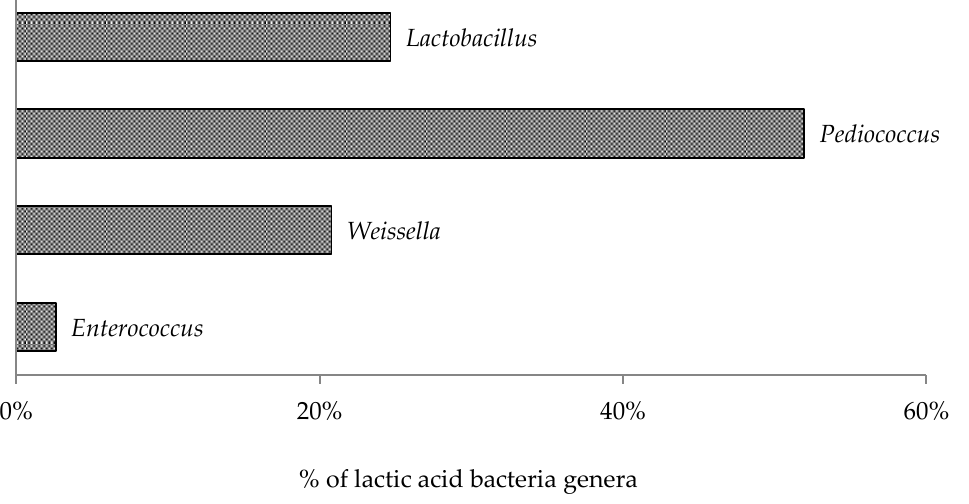
Figure 2. Frequency of lactic acid species isolated from alfalfa silage through the fermentation period (56 days).